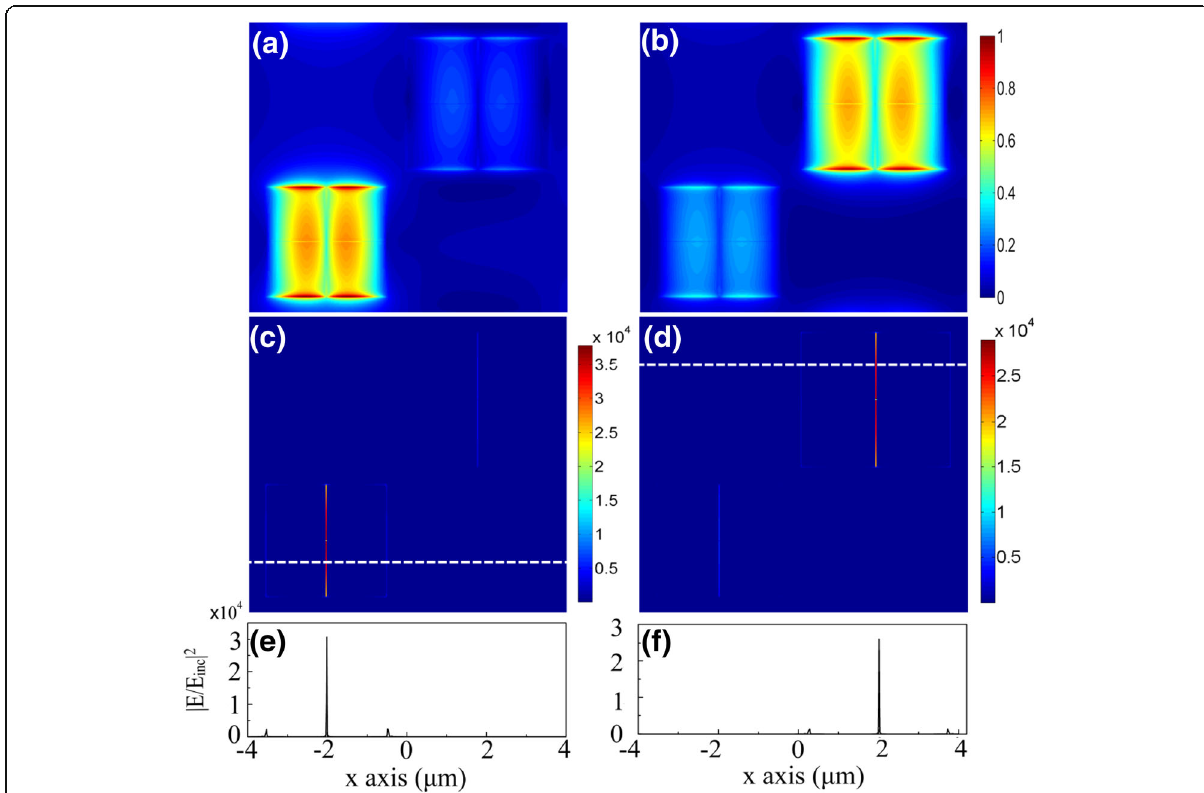
Fig. 3 Field distributions in the graphene layer at E F = 0.2 eV for the x-polarized light at the normal incidence, showing great enhancement in the slot caused by the coupled-resonances. a, b Normalized magnetic field |H| 2 at λ 1 = 11.8 μ m ( a ) and λ 2 = 12.46 μ m ( b ); c , d The corresponding field distribution of |E/E inc | 2 ; e , f |E/E inc | 2 along the white dash-line shown in c and d , respectively. A sharp contrast is seen between the intensity inside the slot and that at the patch edges, giving hints for much wider tuning range than that in previous